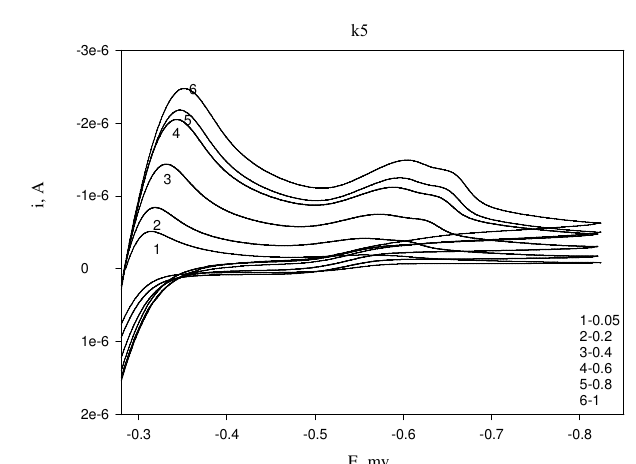
Figure 4. CVs of II in DMF-THAC at HMDE versus Ag/AgCl electrode at various scan